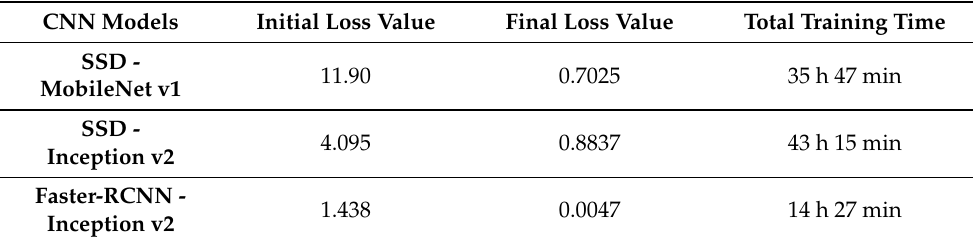
Table 3. CNN trained models’ loss values and total training time.